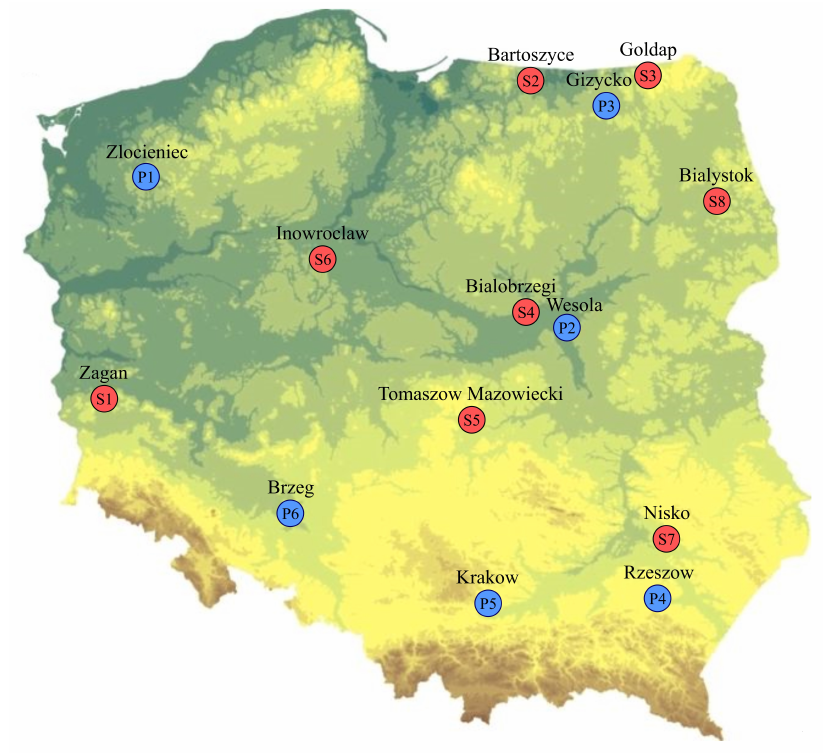
Figure 2. Location of suppliers and recipients in territory of Poland.